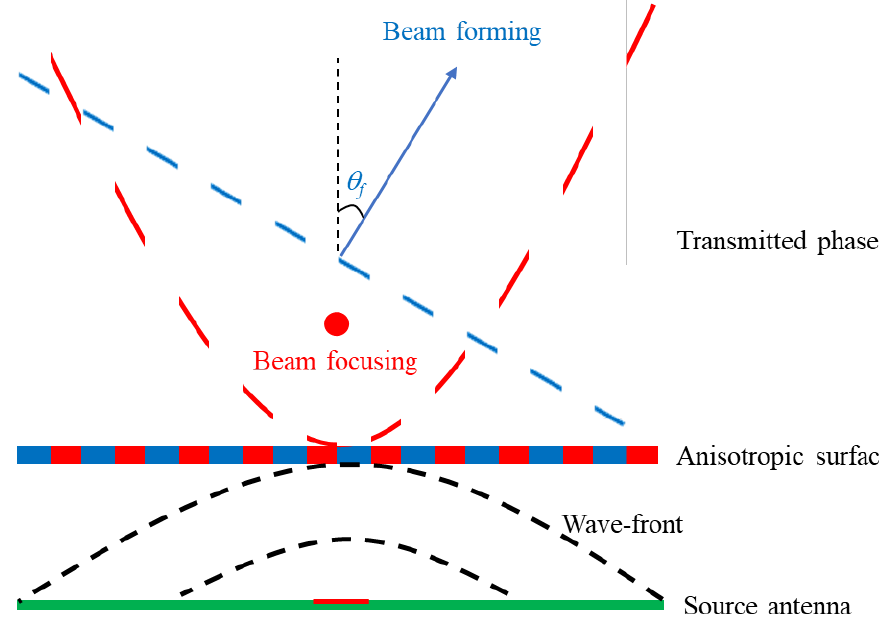
Figure 3. Relation between beam and transmitted phase through anisotropic surface.